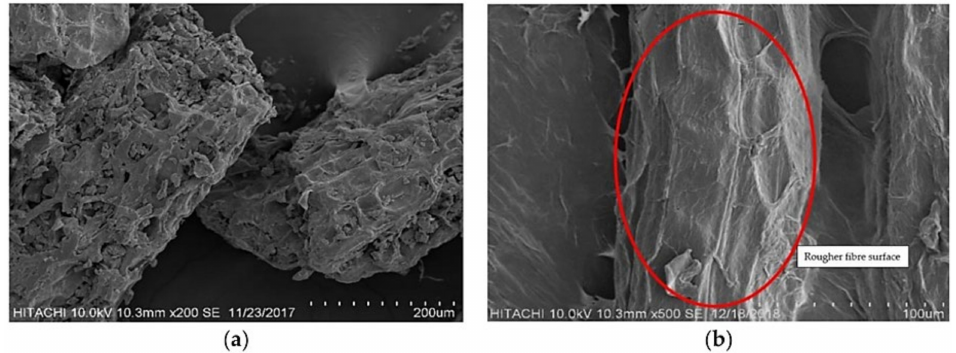
Figure 6. Scanning electron microscopy (SEM) micrographs of ( a ) unbleached jackfruit skin powder (JSP) and ( b ) bleached jackfruit skin powder (BJSP). Reproduced with permission from Ref. [79]. Copyright 2021